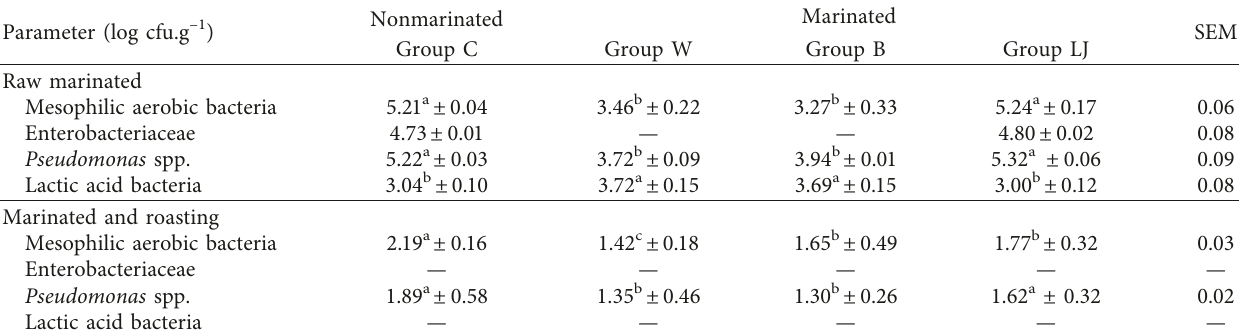
Table 2: Microbiologial composition of nonmarinated and marinated breast muscles of slaughter pheasants. Parameter (log cfu.g –1 )